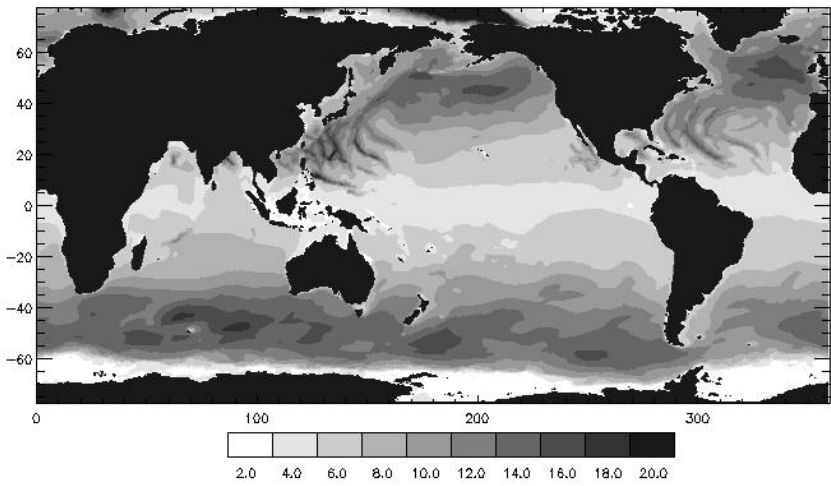
Figure 6. Wave heights above mean level (m) with a cumulative probability of 10 − 7 , averaged for